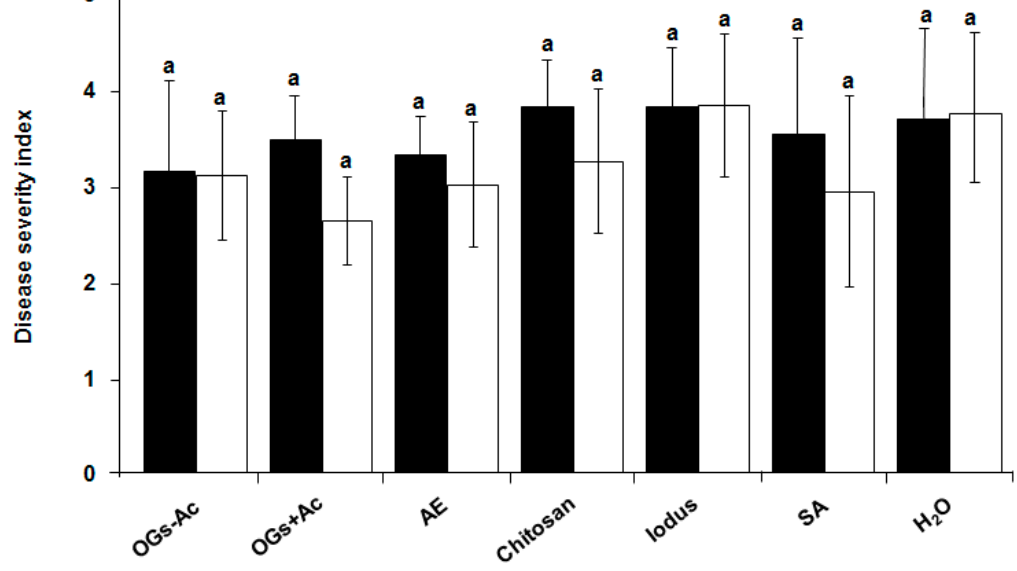
Figure 2. Pea root rot disease severity index at 10 days after inoculation with Aphanomyces euteiches at 10 5 zoospores/plant at 5-week-old. The upper plant rachis was injected with elicitors (20 µg/rachis) at two (white) or one (black) weeks before inoculation. OGs − Ac; nonacetylated oligogalacturonides, OGs + Ac; acetylated oligogalacturonides, AE; an inoculum of A. euteiches zoospores (10 5 zoospores. mL − 1 ) heated at 100 °C for 10 min, Chitosan, Iodus, SA; salicylic acid. Controls were injected with water. The values shown are means with SD ( n = 5). Different lower-case letters indicate significant differences between treatments according to the Tukey test ( p ≤ 0.05).